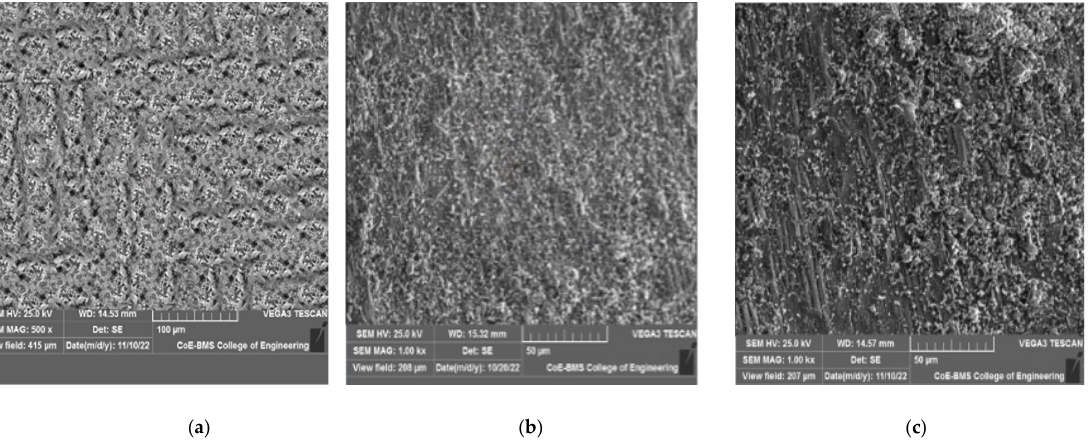
Figure 9. SEM images of a FSPed AA7075/ Gr sample prepared at (a) 1400 rpm and 45 mm/min, ( b ) 2000 rpm and 35 mm/min, and ( c ) 2000 rpm and 45 mm/min.